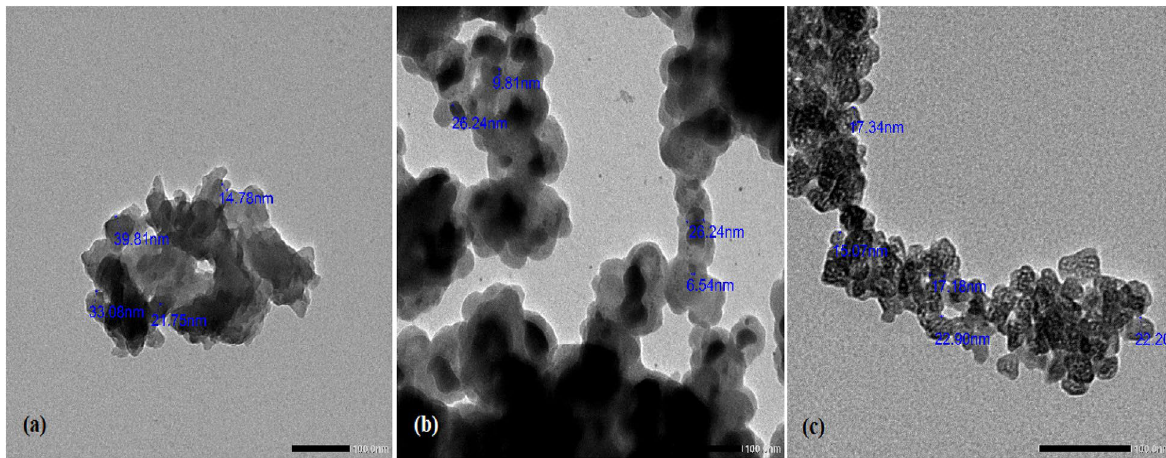
Fig. 4 TEM images of: a copolymer 6; b SiO 2 /Ag composite 3; and c copolymer/L-hexuronic acid/SiO 2 @Ag nanocomposite